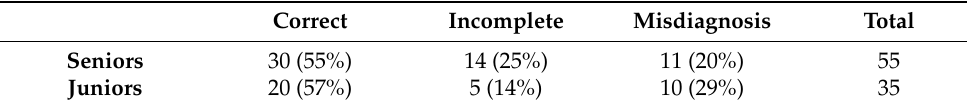
Table 2. Diagnostic accuracy among senior and junior